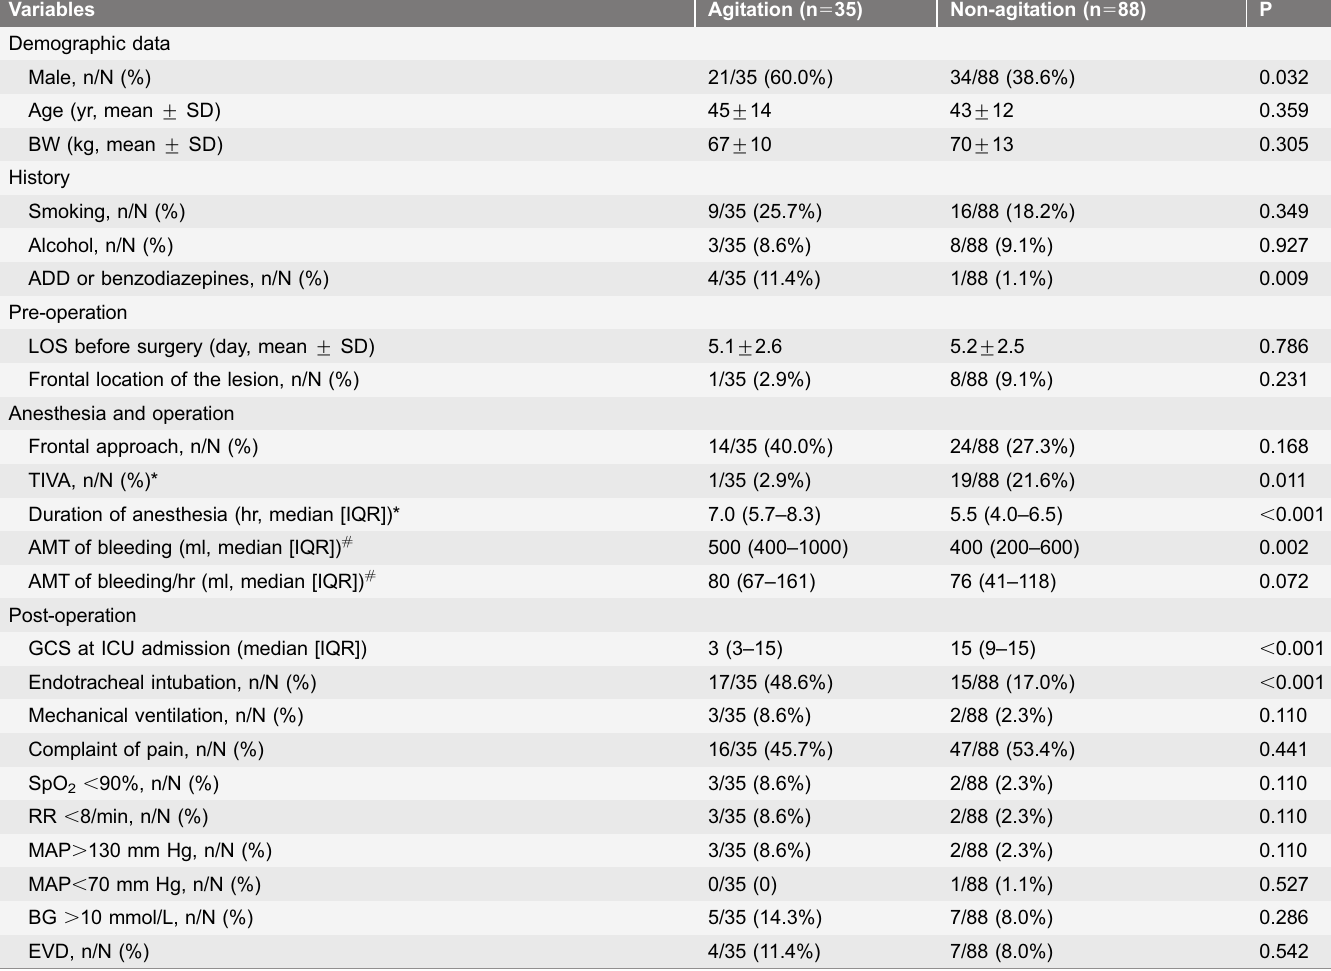
Table 2. Patient variables in the agitation and non-agitation